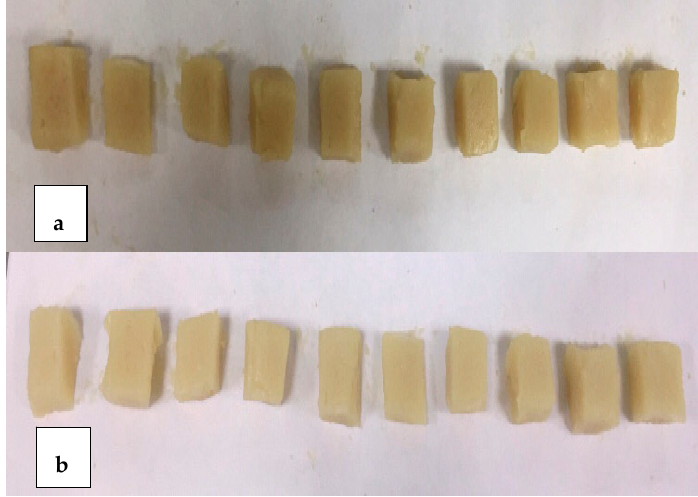
Figure 3. Effect of salt ion addition before spray drying on the gel whiteness of soy protein isolate: ( a ) heat-induced gels; ( b ) cold-induced gels.